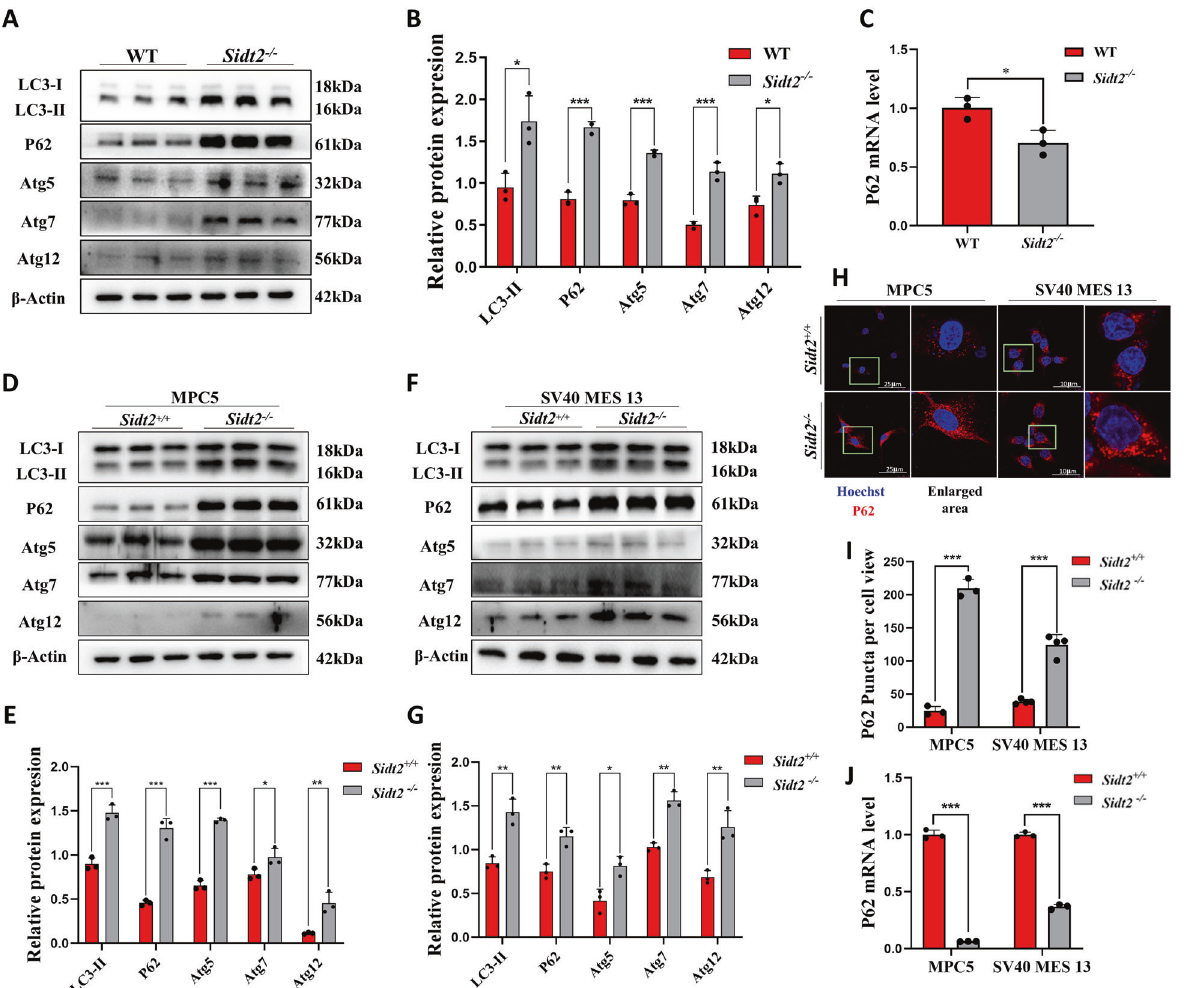
Fig. 3 Sidt2 deletion disrupts the autophagy pathway. A Detection of WT and Sidt2 − / − cell autophagy-related protein expression levels by western blot; B statistical charts of the western blot test results; C P62 mRNA expression level in kidney tissues of WT and Sidt2 − / − mice; D expression levels of MPC5 cell autophagy pathway proteins before and after Sidt2 knockout; E statistical graph of ( D ) chart; F expression levels of autophagy pathway proteins in SV40 MES 13 cells before and after Sidt2 knockout; G statistical chart of the ( F ) chart; H P62 immuno fl uorescence in MPC5 and SV40 MES 13 cells before and after Sidt2 knockout; I statistical charts of the immuno fl uorescence results; J P62 mRNA expression levels in MPC5 and SV40 MES 13 cells before and after Sidt2 knockout. * P < 0.05, ** P < 0.01, *** P <